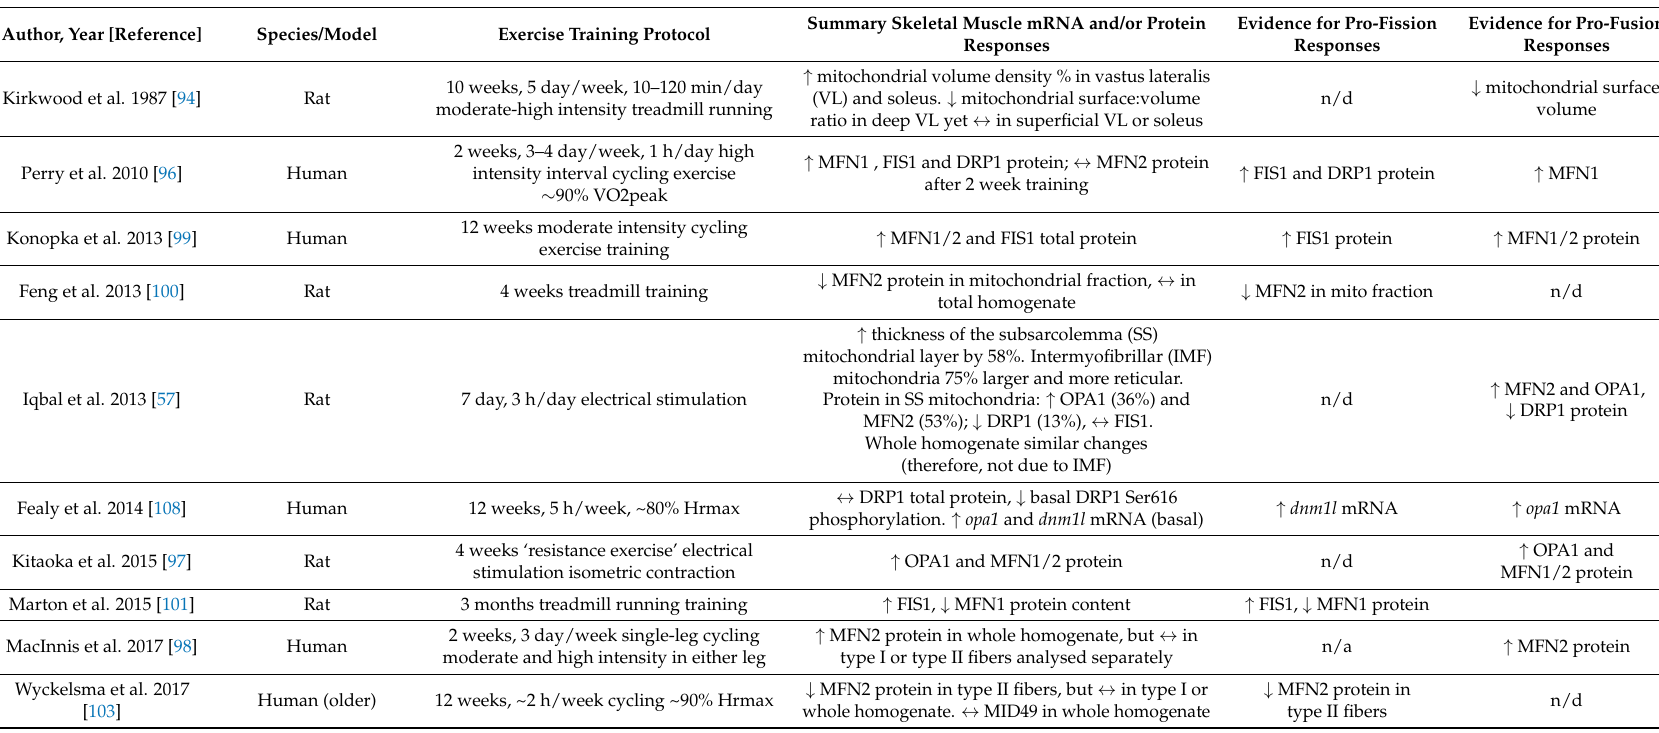
Table 2. Effects of long-term exercise training on mitochondrial fission/fusion mRNA and protein